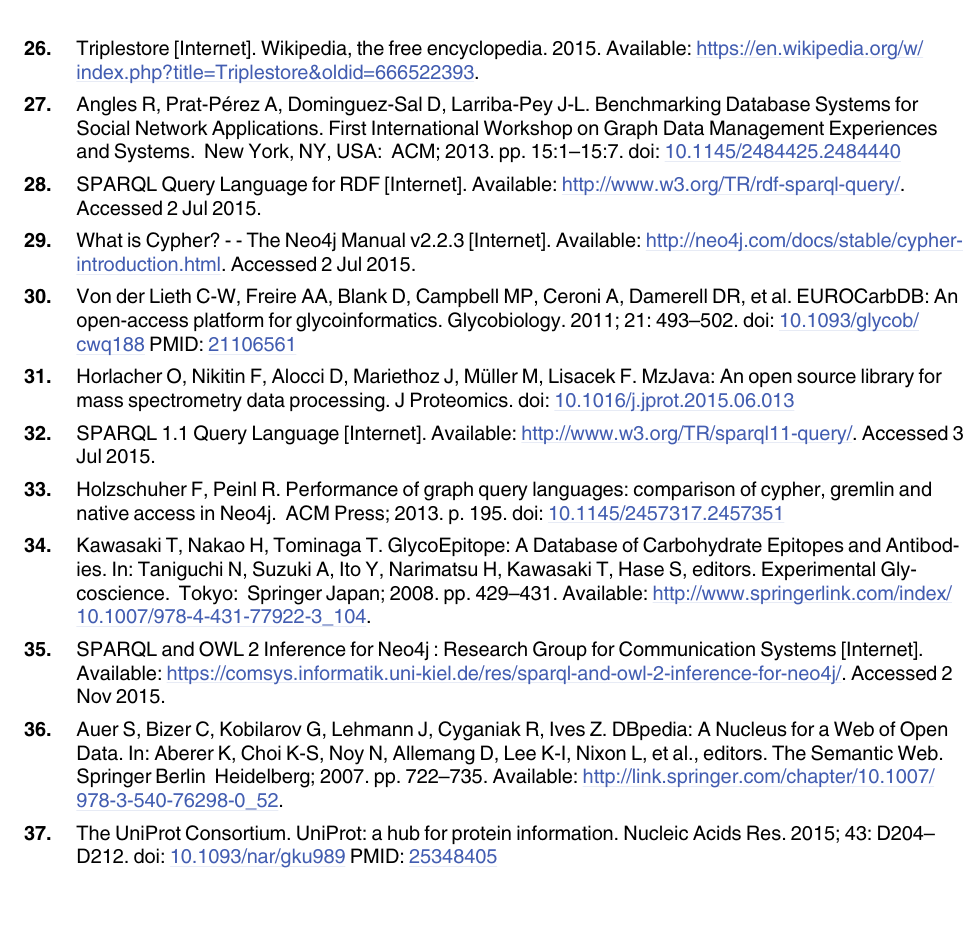
PLOS ONE | DOI:10.1371/journal.pone.0144578 December 14,